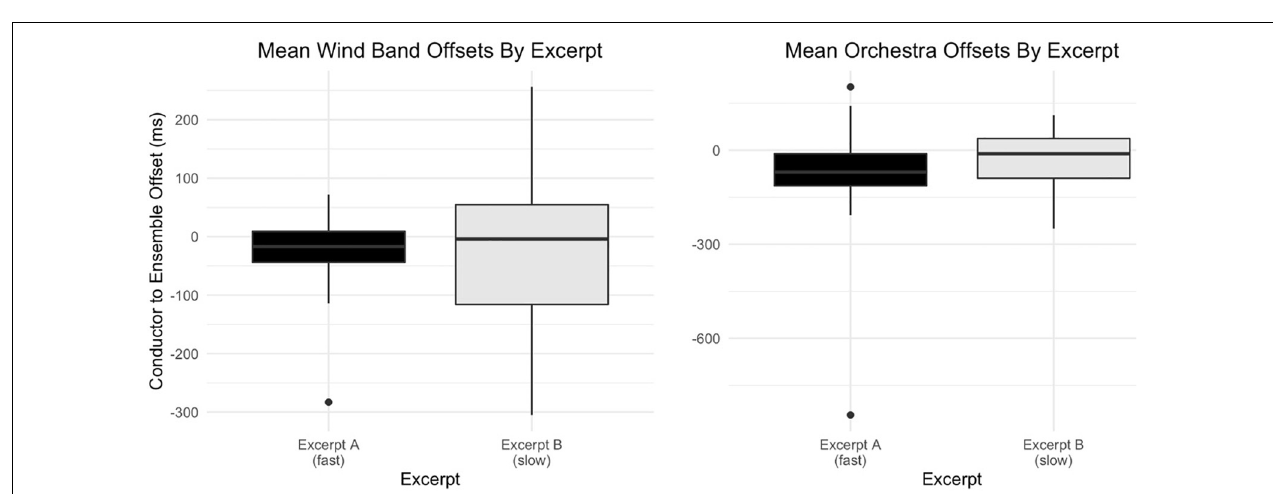
FIGURE 4 | Mean offsets by ensemble and excerpt. Mean offset values by ensemble type and excerpt condition (fast, slow). Negative offset values indicate a conductor-led or sight-first relationship.